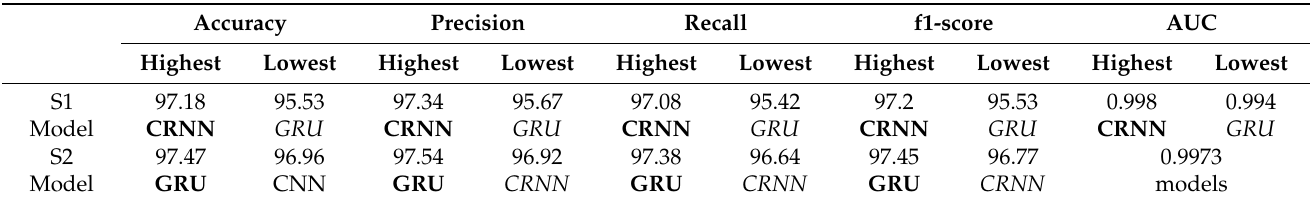
Table 12. Recapitulation of the average values of accuracy, precision, recall, f1-score, and AUC for 3 models with 128 (S1 set) and 153 (S2 set) feature